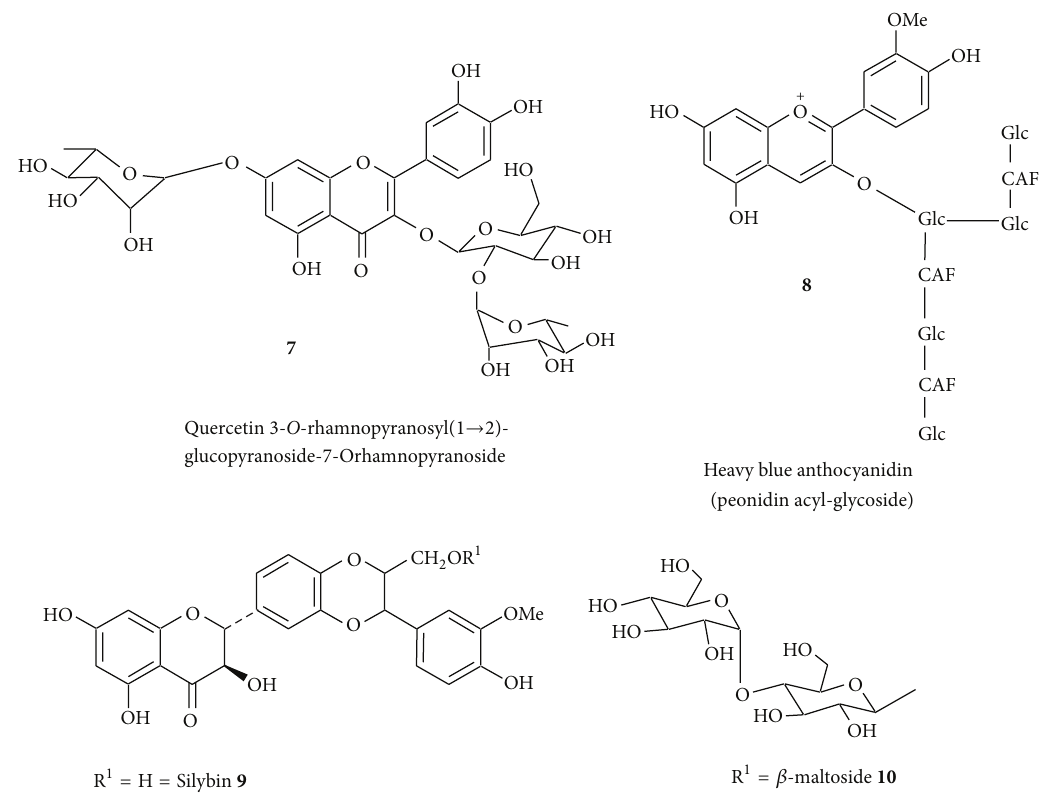
Figure 2: Natural polyphenolic flavonoid